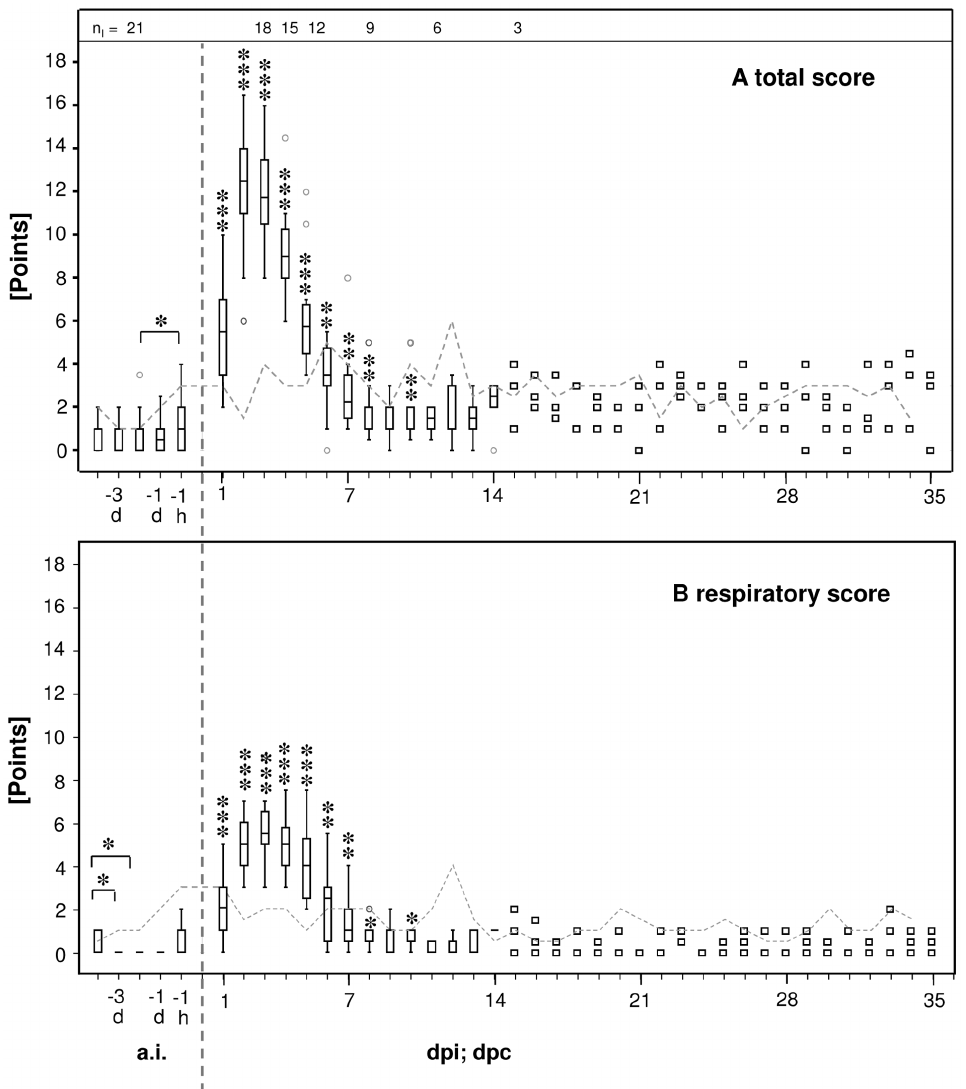
Figure 2. Score of clinical and respiratory health before and after C.psittaci challenge. General clinical score (panel A) and respiratory signs (panel B) peaked in the inoculated group 2–3 dpi. Symptoms resolved incompletely. The respiratory score contributed maximally 50% to the general clinical picture presented by the total score. In contrast, natural acquisition of C. psittaci infection lead only to mild symptoms in sentinel calves. Based on the group size of calves inoculated with 10 8 ifu/animal (n I given above panel A) data are given as Box and Whisker plots or as individual data (squares) if n # 3, respectively. The dashed line indicates the maximum of score points achieved in sentinels (n=3). For statistical analysis, baseline data (averaged per animal) were compared to data obtained at different time points after challenge (Wilcoxon signed-rank test). Values of * P # 0.05, ** P # 0.01, and *** P # 0.001 were considered significant. Outlier values are indicated by small grey circles. a.i ante infectionem . d day. dpi days post inoculation. dpc days post contact to inoculated calves. h